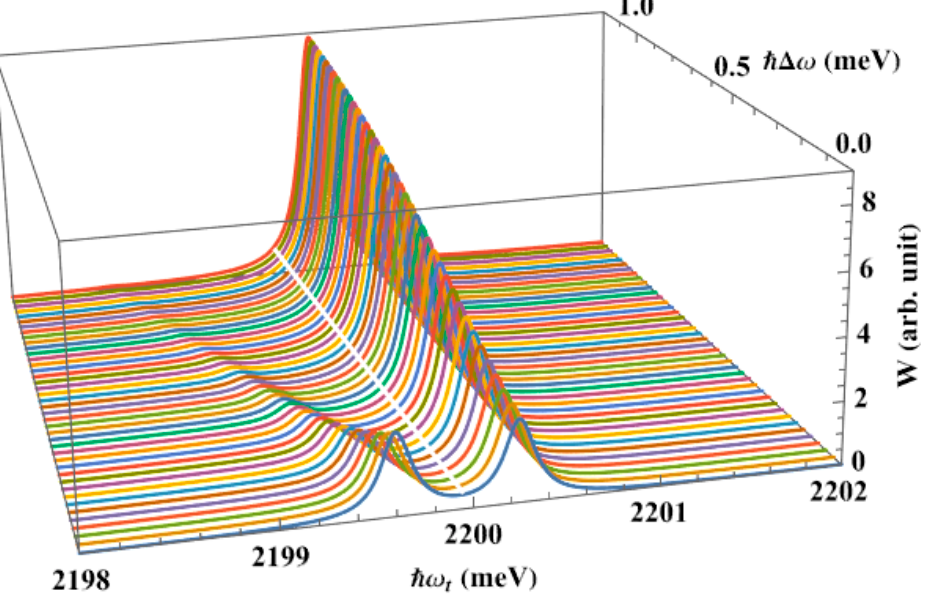
Figure 7. The interband absorption spectra in the presence of the pump laser, as a function of the pump laser’s detuning, with R = 50 Å and θ 0 = 60 ◦